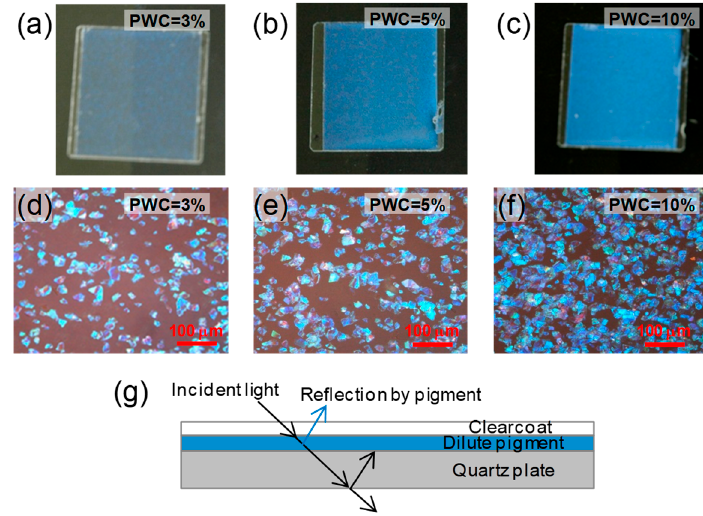
Figure 2. ( a – c ) Images of the dilute mica pigment coated on a glass plate with varying PWCs; ( d – f ) Optical microscope images of the dilute mica pigment; ( g ) Schematic cross-sectional view of the fabricated sample. The black arrow represents incident light, while the blue arrow represents the light reflected by the pigment.